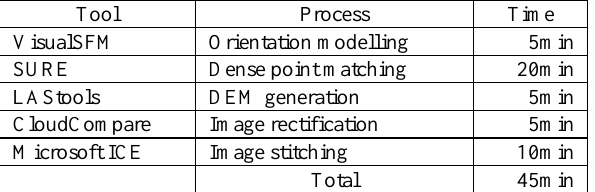
Table 3. Computational time for 4 overlapped UAS images Figure 6. Visualization in